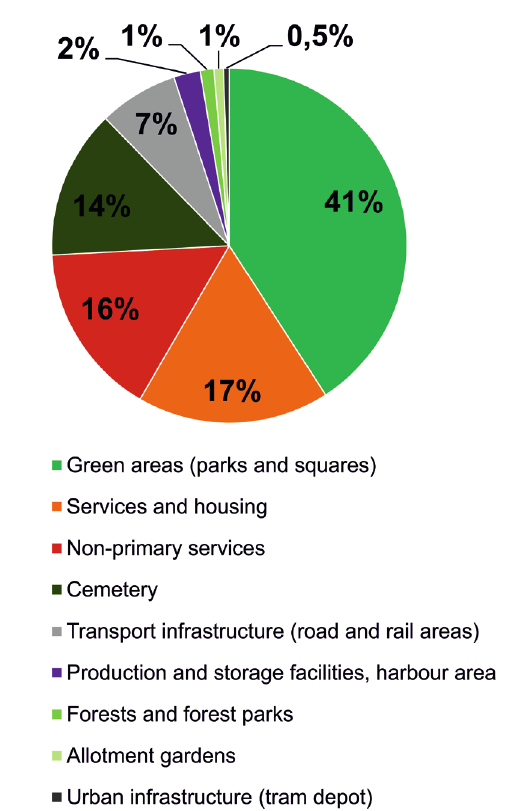
Figure 14. Planned land-use designations of the post-cemetery